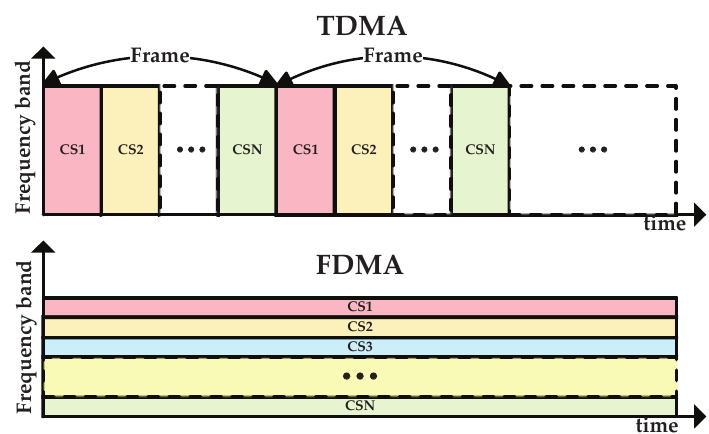
Figure 7. Frame structures of time division multiple access and frequency division multiple